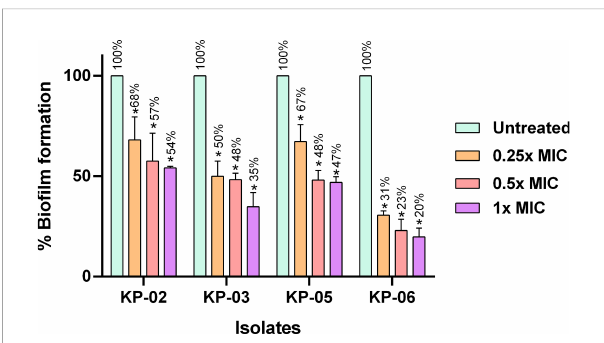
FIGURE 2 Inhibition of the growth of MDR/XDR K. pneumoniae bio fi lms. K11 was incubated with strong bio fi lm producers of K. pneumoniae at 0.25×, 0.5×, and 1×MIC of the peptide. The untreated bar indicates MDR/XDR K. pneumoniae bio fi lm without any antimicrobial agent. Crystal violet was used to determine the total biomass of the bio fi lm. The data were analyzed by one-way ANOVA; *P value <0.05. Percent numbers indicate % bio fi lm formation.